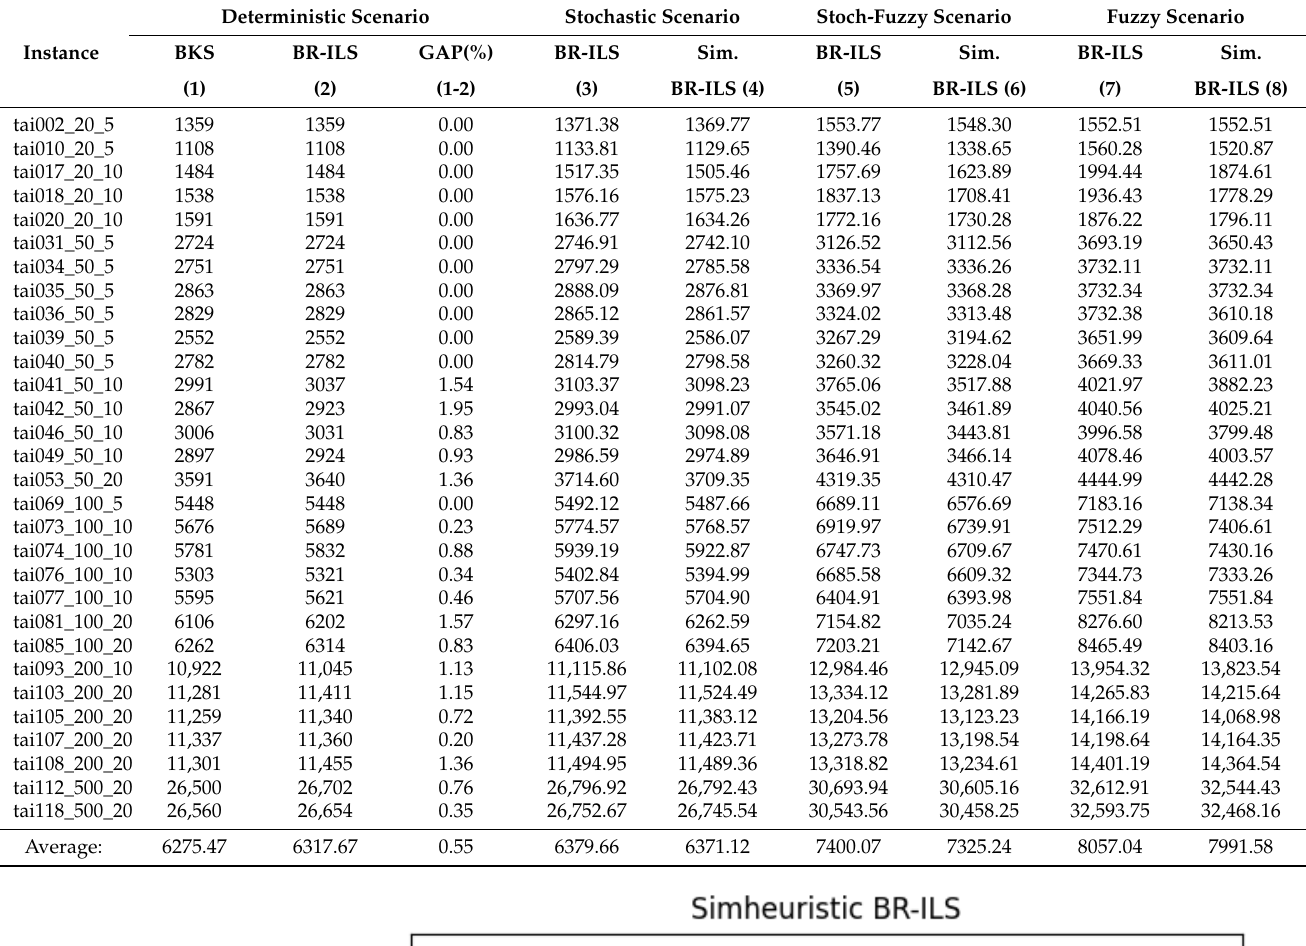
Table 2. Results of the the four considered scenarios of the PFSP.